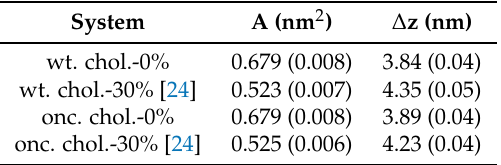
Table 1. The average area per lipid (A) and thickness ( ∆ z) of the anionic membrane for four KRas-4B-Far systems studied in this work. The thickness of the membrane ∆ z by computing the mean distance between phosphorus atoms of DOPC head groups from both leaflets. Estimated errors in